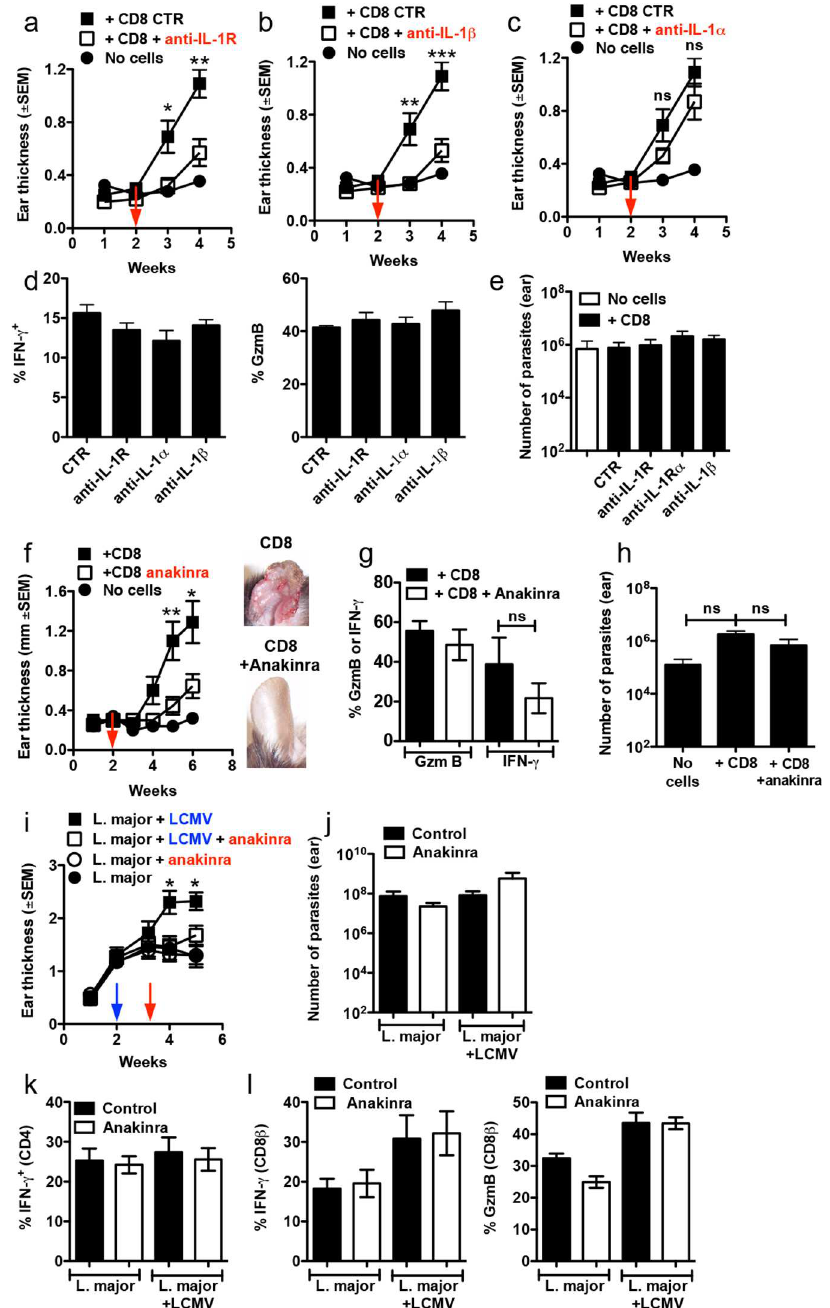
Fig 2. Immunopathology caused by CD8 T cells is IL-1 β -dependent. RAG-/- mice were infected with L . braziliensis in the ear, and reconstituted with CD8 T cells or did not receivecells and at 2 weeks post infection mice were treated with (a) anti-IL-1RmAb, (b) anti-IL-1 β mAb (c) anti-IL-1 α mAb or (f) anakinra; ear thickness was assessedweekly. (d) 4 weeks or (g) 6 weeks post infection mice were euthanizedand lesionswere digestedand used for flow cytometric analysisof intracellularIFN- γ and GzmB on CD8 T cells. (e and h) Parasite burdenin the lesions. Graphs are data combinedfrom 2 independentexperiments (n = 3 to 5 mice per group in each experiment). C57BL/6mice were infected with L . major in the ear, and 2 weeks later mice were co-infectedwith 2 × 10 5 PFU of LCMV Armstrong strain by i.p. injection.Ten days post LCMV infection mice were treated with anakinra or were left untreated; (i) ear thickness was assessed weekly. Five weeks post infection with L . major , mice were euthanized and the (j) number of parasites in the skin was determined and lesionswere digestedand used for flow cytometric analysisof intracellular IFN- γ , and GzmB on (k) CD4